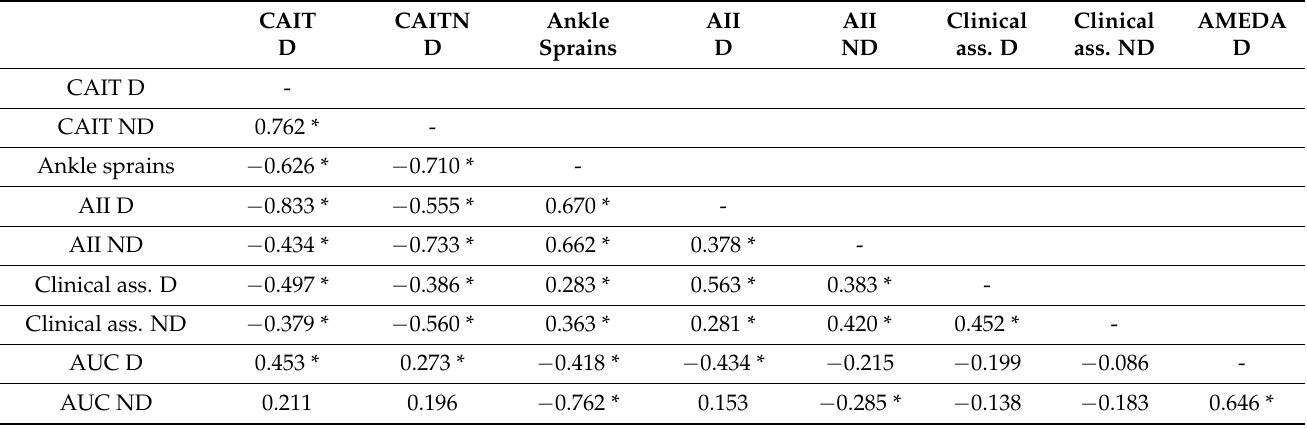
Table 1. Correlations (Pearson’s r values) between the different mechanical and functional ankle instability assessments for the dominant (D) and non-dominant legs